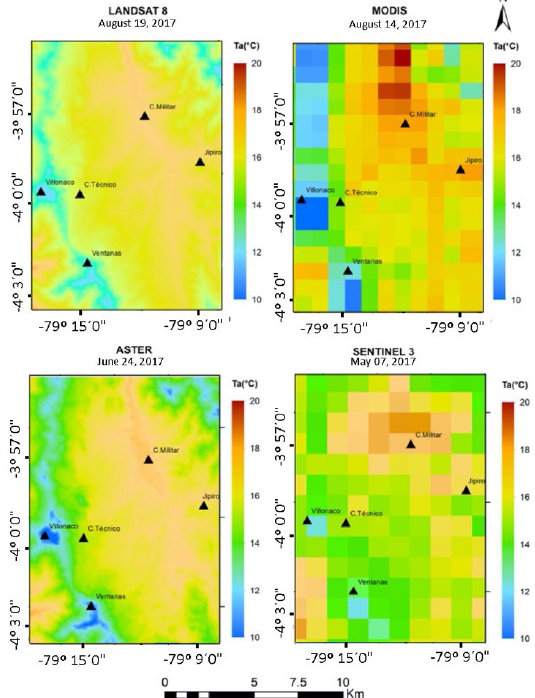
Figure 3. Air temperature ( ◦ C) for the different satellite products. The spatial variation of the net radiation is presented in Figure 4. The highest values are located in the areas with the highest elevation, which are covered by forests in good condition. The spatial variability of the ETo is high (Figure 5) due to the variable conditions of temperature, net radiation, wind speed, etc.